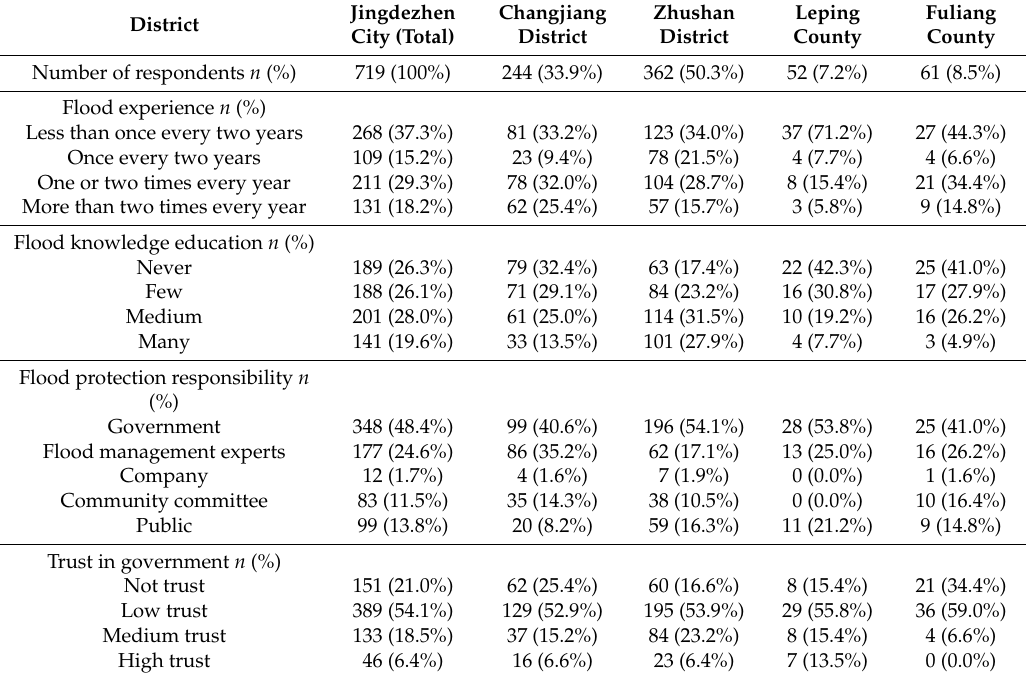
Table 3. The distribution of the respondents regarding flood experience and trust in government (N =